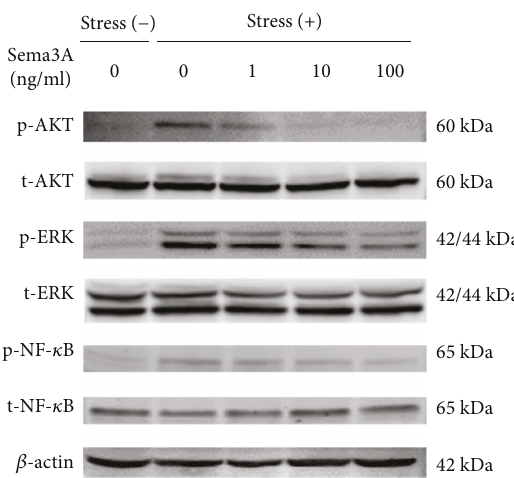
Figure 7: E ff ect of Sema3A on activation of AKT, ERK, and NF- κ B phosphorylation. ATDC5 cells treated with various concentrations of Sema3A (1, 10, or 100 ng/ml) were subjected to CTS for 1h. Whole cell lysates were subjected to Western blot